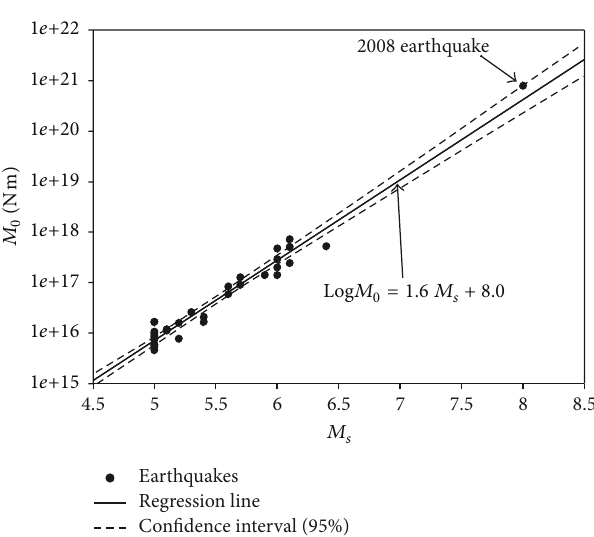
Figure 3: Regression line of seismic moment ( 𝑀 0 ) and surface magnitude ( 𝑀 𝑠 ). Data include the main shock and 33 aftershocks with 𝑀 𝑠 ≥ 5.0 during the 2008 earthquake